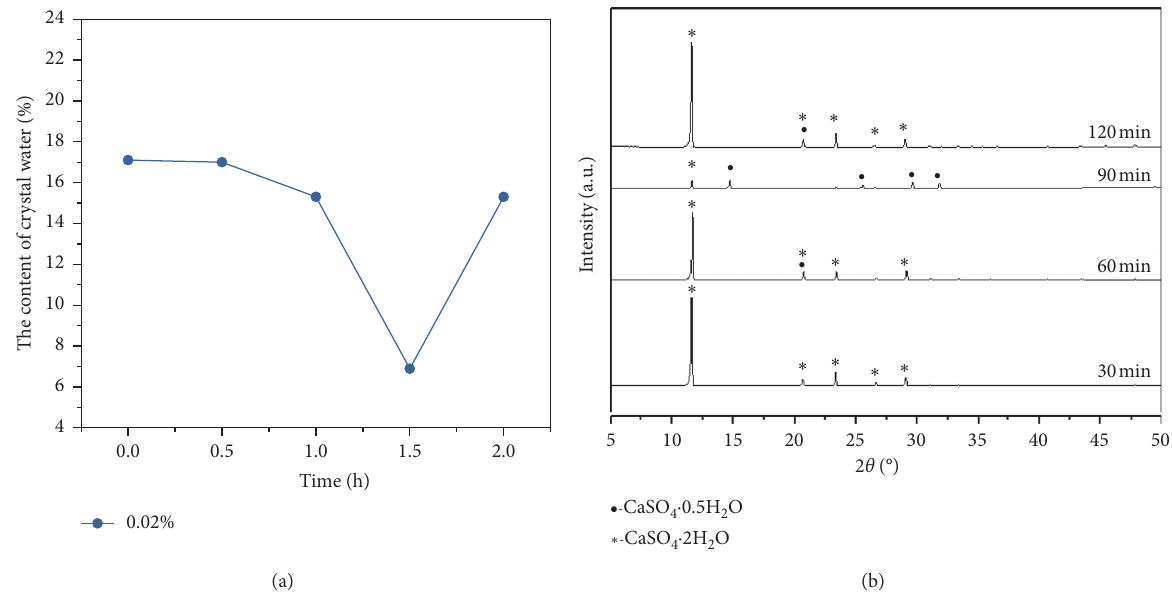
Figure 13: Solid-phase crystallization water content and XRD patterns obtained under different reaction times in the presence of 0.02% succinic acid.